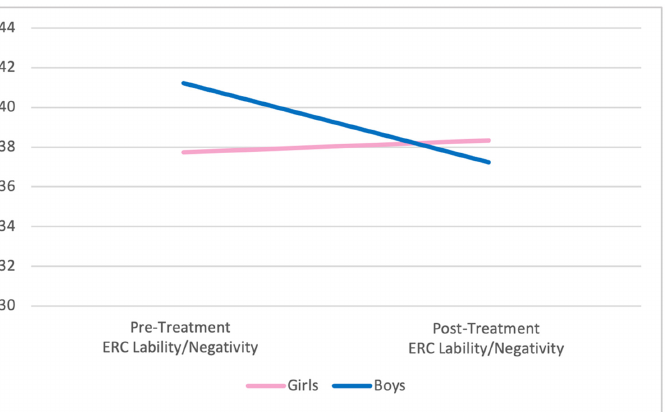
Figure 1. Pre- and post-treatment lability/negativity by gender. Notes. No significant differences comparing pre-/post-treatment or comparing boys to girls. ERC = Emotion Regulation Checklist.